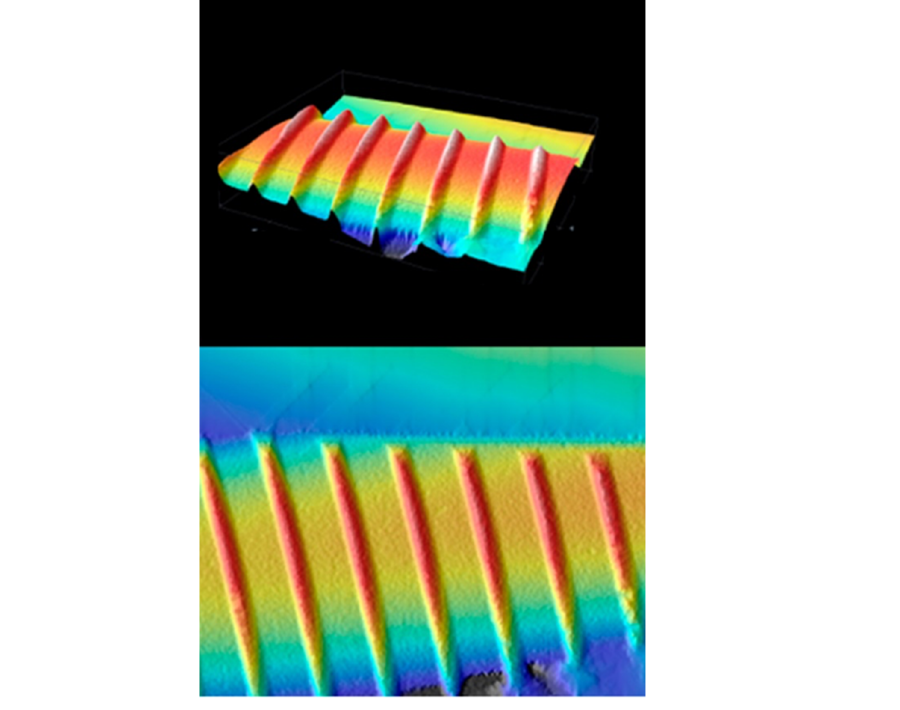
Figure 1. SLA surface confocal microscopy.